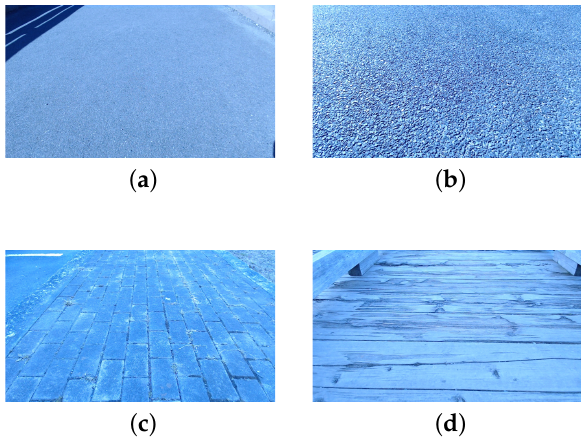
Figure 2. Artificial terrains. ( a ) Slick asphalt; ( b ) Granulated asphalt; ( c ) Tiles; ( d ) Wood.